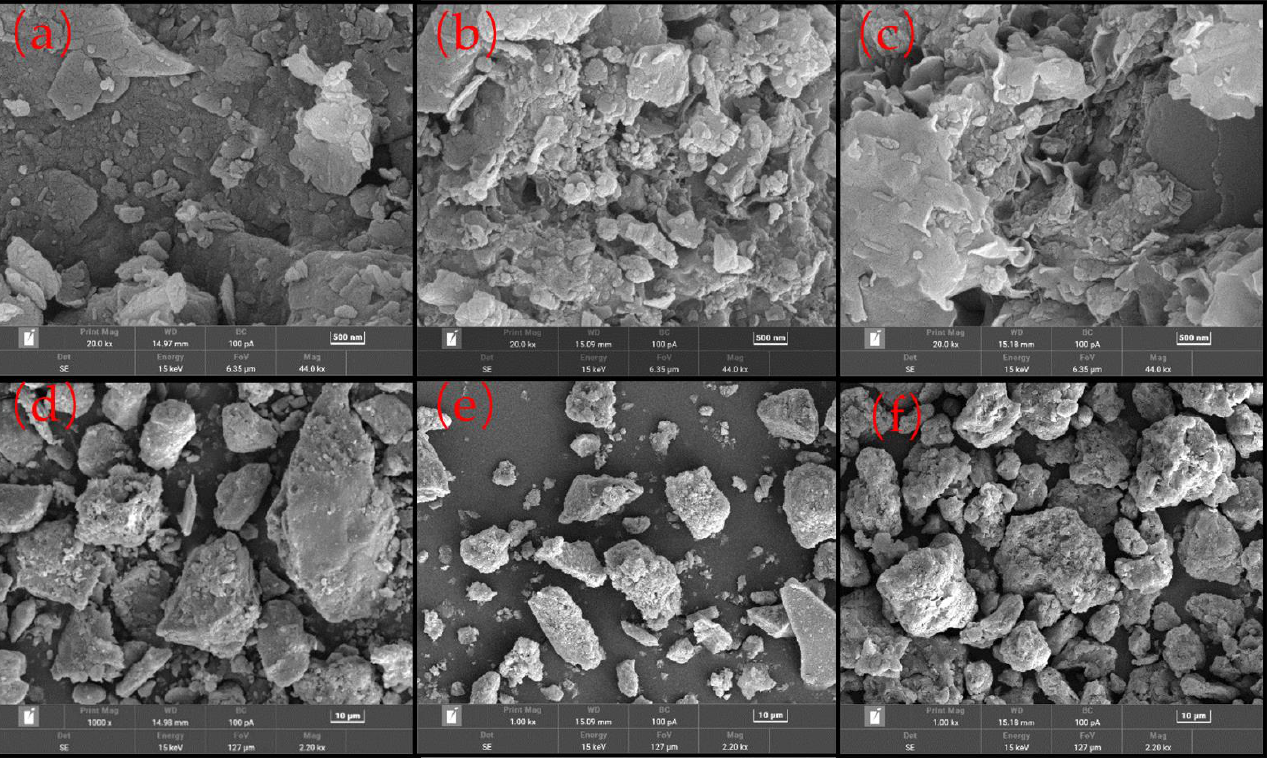
Figure 3. SEM images of materials: ( a ) silt with particle size under 75 μm in SSTS (500 nm), ( b ) stone powder in M-S (500 nm), ( c ) sodium bentonite (500 nm), ( d ) silt with particle size under 75 μm in SSTS (10 μm ), ( e ) stone powder in M-S (10 μm ), and ( f ) sodium bentonite (10 μm ).